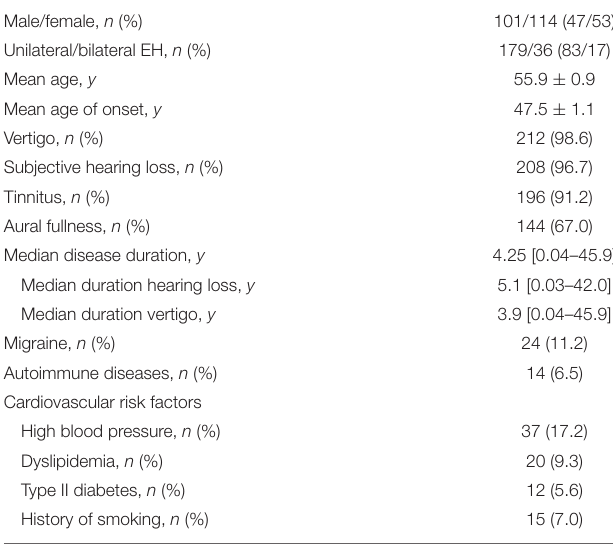
TABLE 2 | Clinical characteristics of patients with HED ( n =